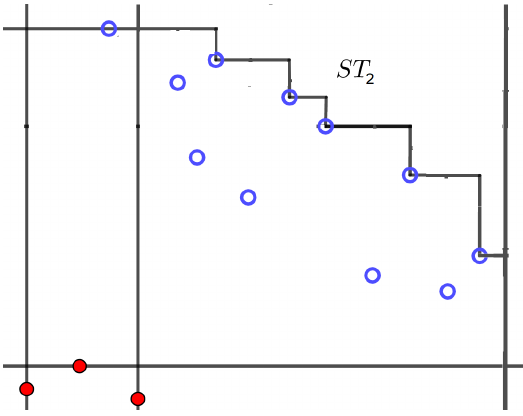
Figure 1. The 2nd level staircase of B NE